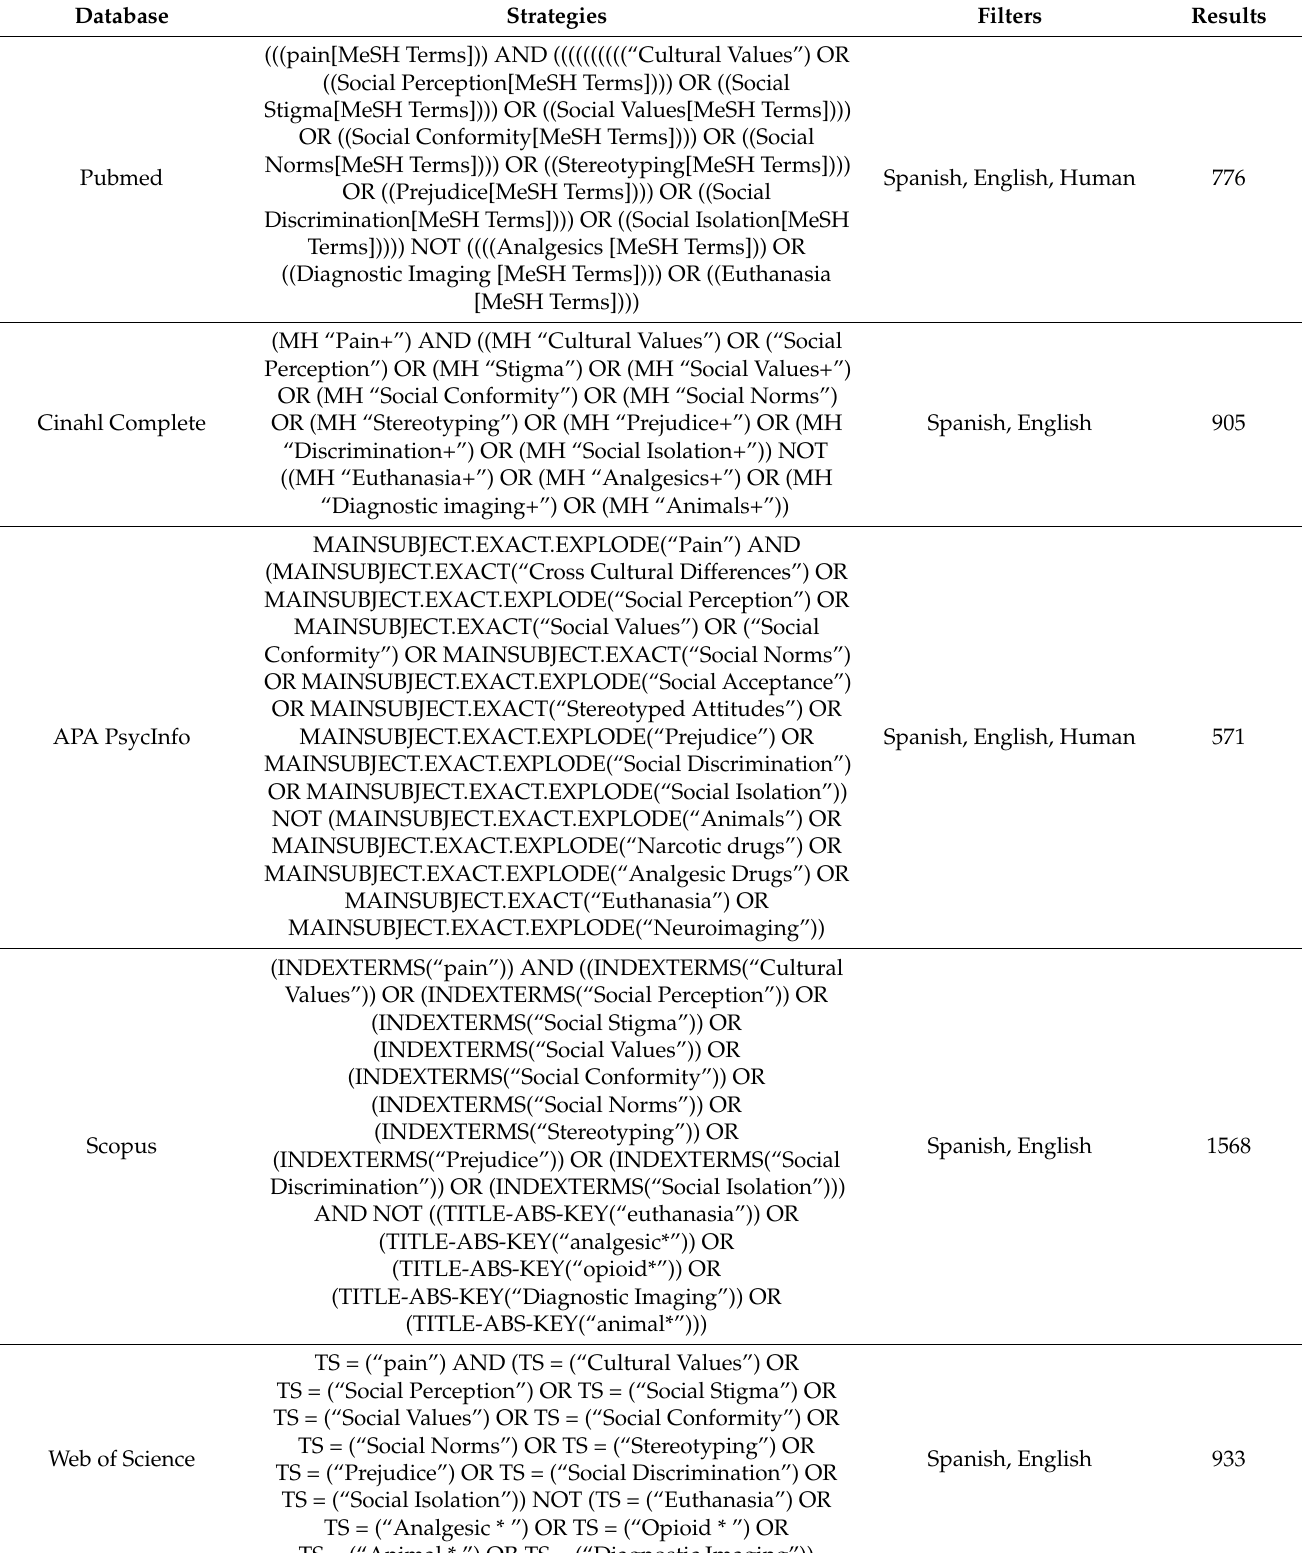
Table 1. Search strategies according to each